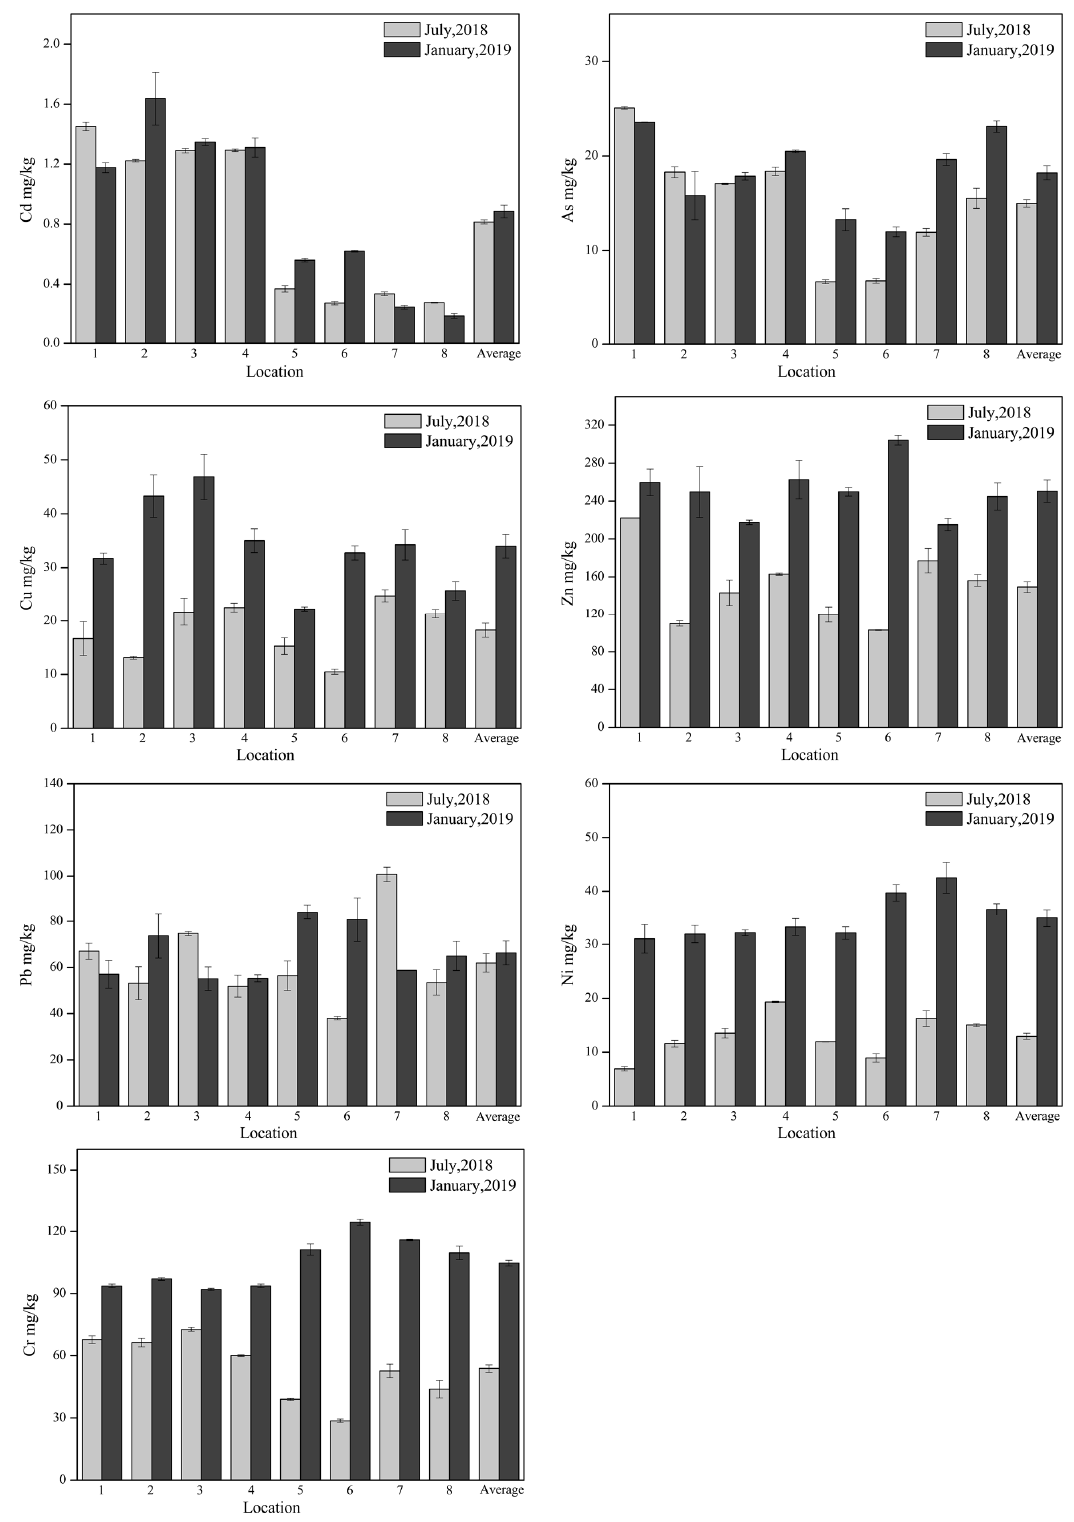
Figure 2. Concentration (mg/kg) of heavy metal in the surface soils collected at a different sampling Figure location.